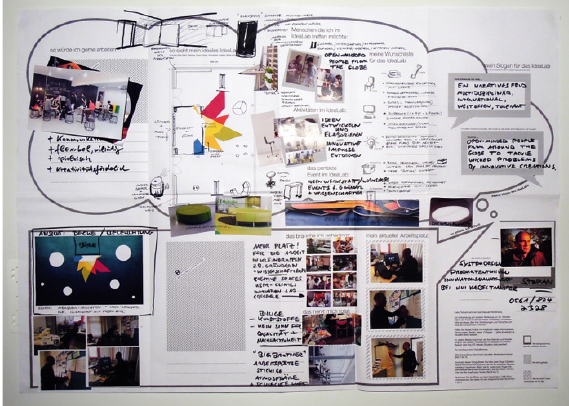
Fig. 4. Exemplary canvas of one participant. In preparation for the workshop, two researchers evaluated the returned data from each poster by extracting and writing down the main insights. The notes were clustered to the point of theoretical saturation (Corbin & Strauss, 2014) until 15 themes